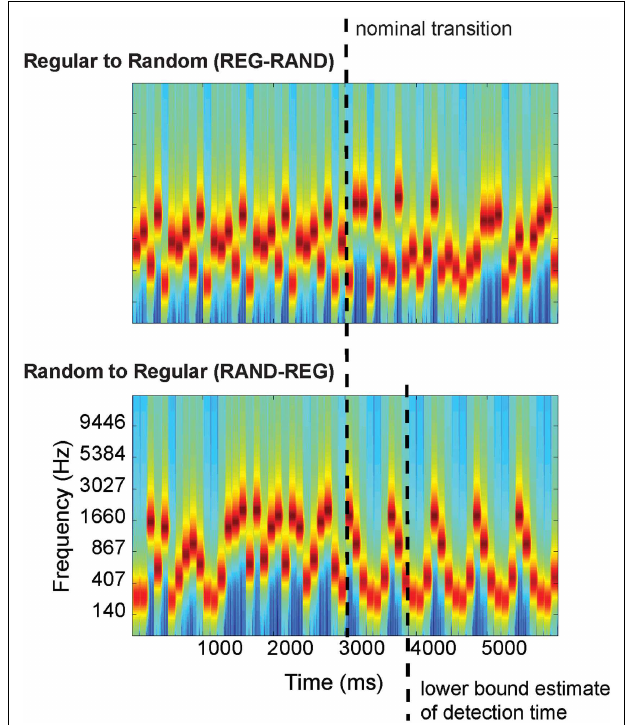
FIGURE 1 | Examples of the auditory stimuli. Top: transition between a regular and random frequency pattern (REG-RAND). Bottom: transition between a random to regular frequency pattern (RAND-REG).The nominal transition, and lower bound estimate of detection time (for RAND-REG; derived in the DETECT block) are indicated with dashed lines.The plots represent “auditory” spectrograms, generated with a filterbank of 1/ERB wide channels (Equivalent Rectangular Bandwidth; Moore and Glasberg, 1983) equally spaced on a scale of ERB-rate. Channels are smoothed to obtain a temporal resolution similar to the Equivalent Rectangular Duration (Plack and Moore,